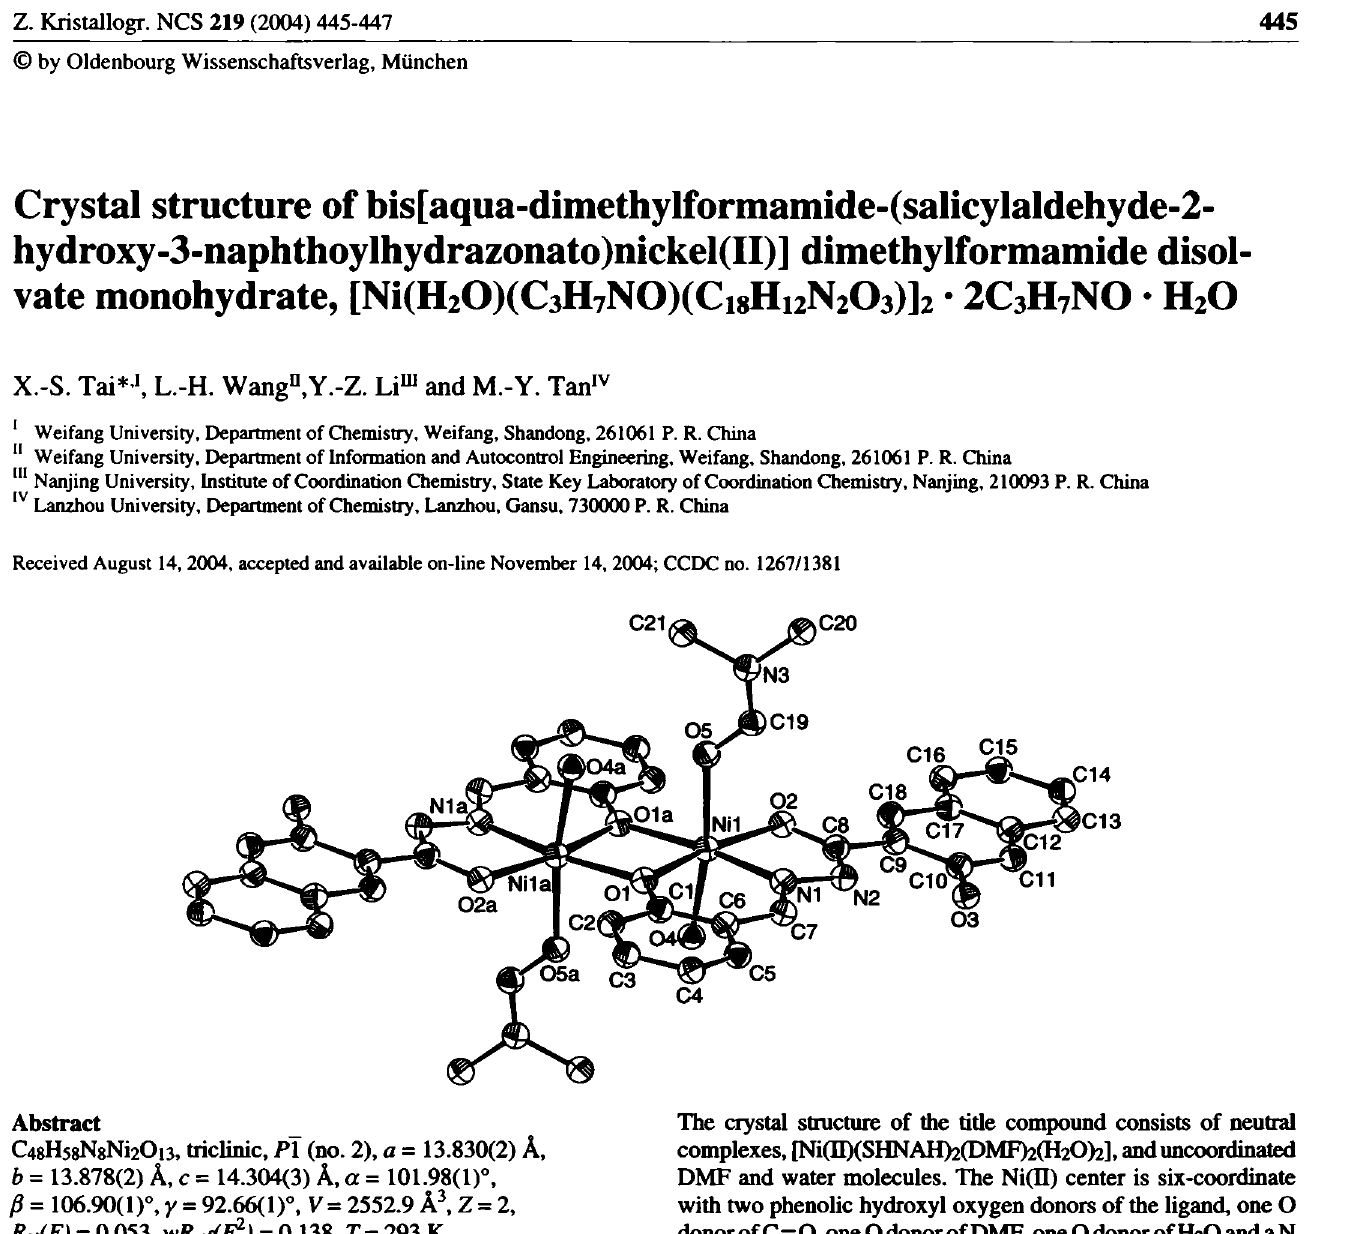
Table 1. Data collection and